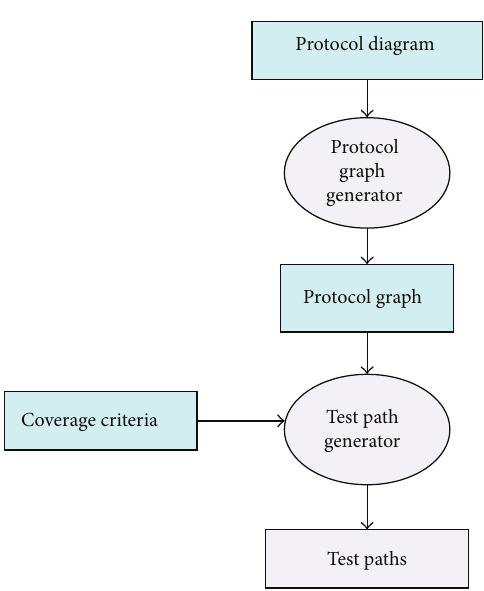
Figure 1: Proposed technique